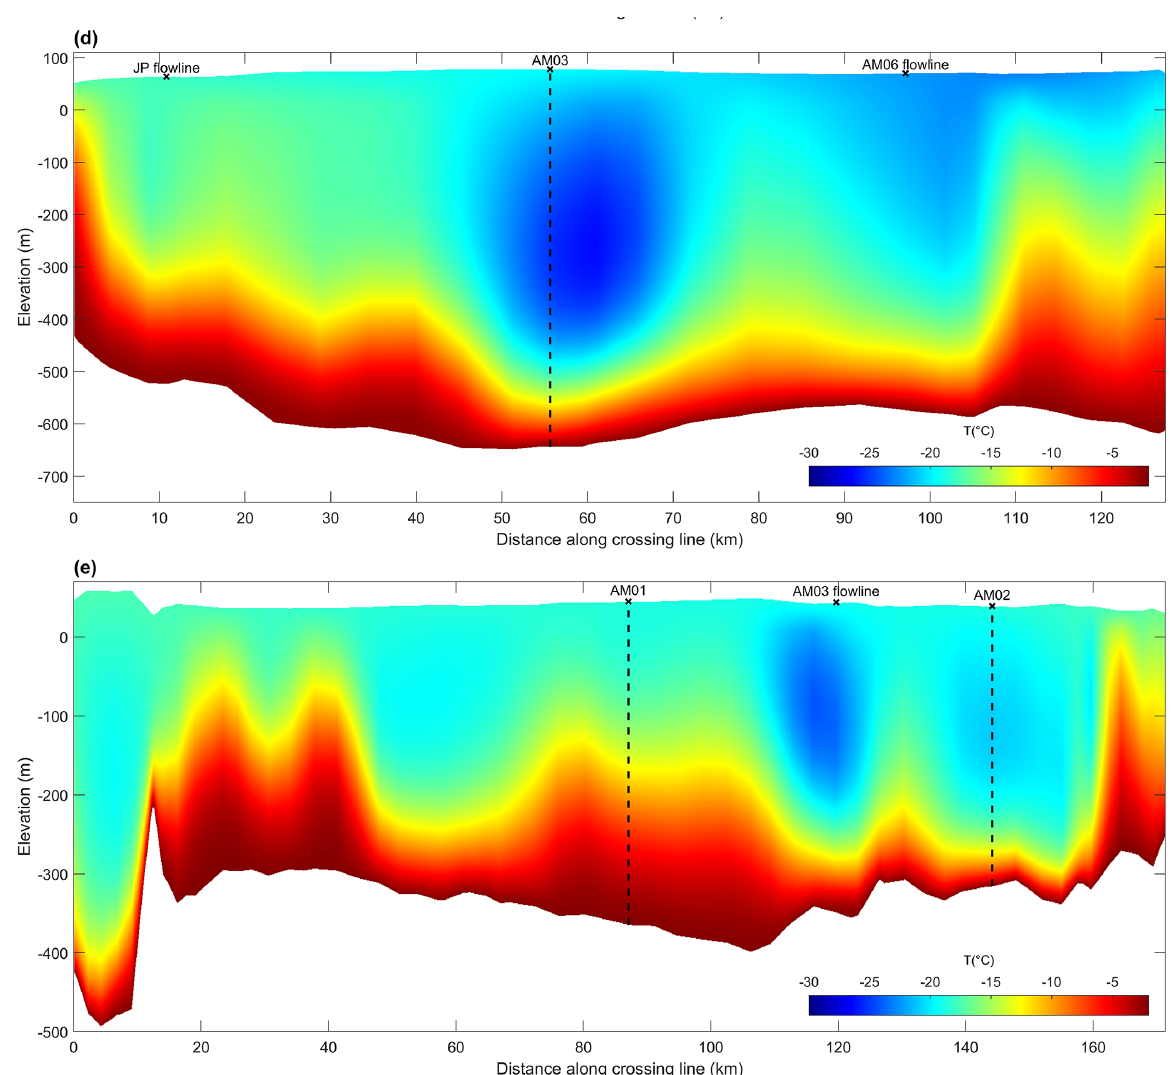
Figure 9. Temperature sections from the 3-D temperature simulation with BMB_CAL, along (a–c) and across (d–e) the three flowlines shown in Fig. 8. The three flowlines are (a) JP flowline, (b) AM03 flowline and (c) AM06 flowline from west to east, derived from the simulated velocity field. In (a) – (c) , the translucent black curve presents the basal mass balance (BMB_CAL) along the flowline. The positions of key points on the flowline are marked; all boreholes are shown with vertical dashed lines. In coordinates, “distance along flowline” is relative to the grounding